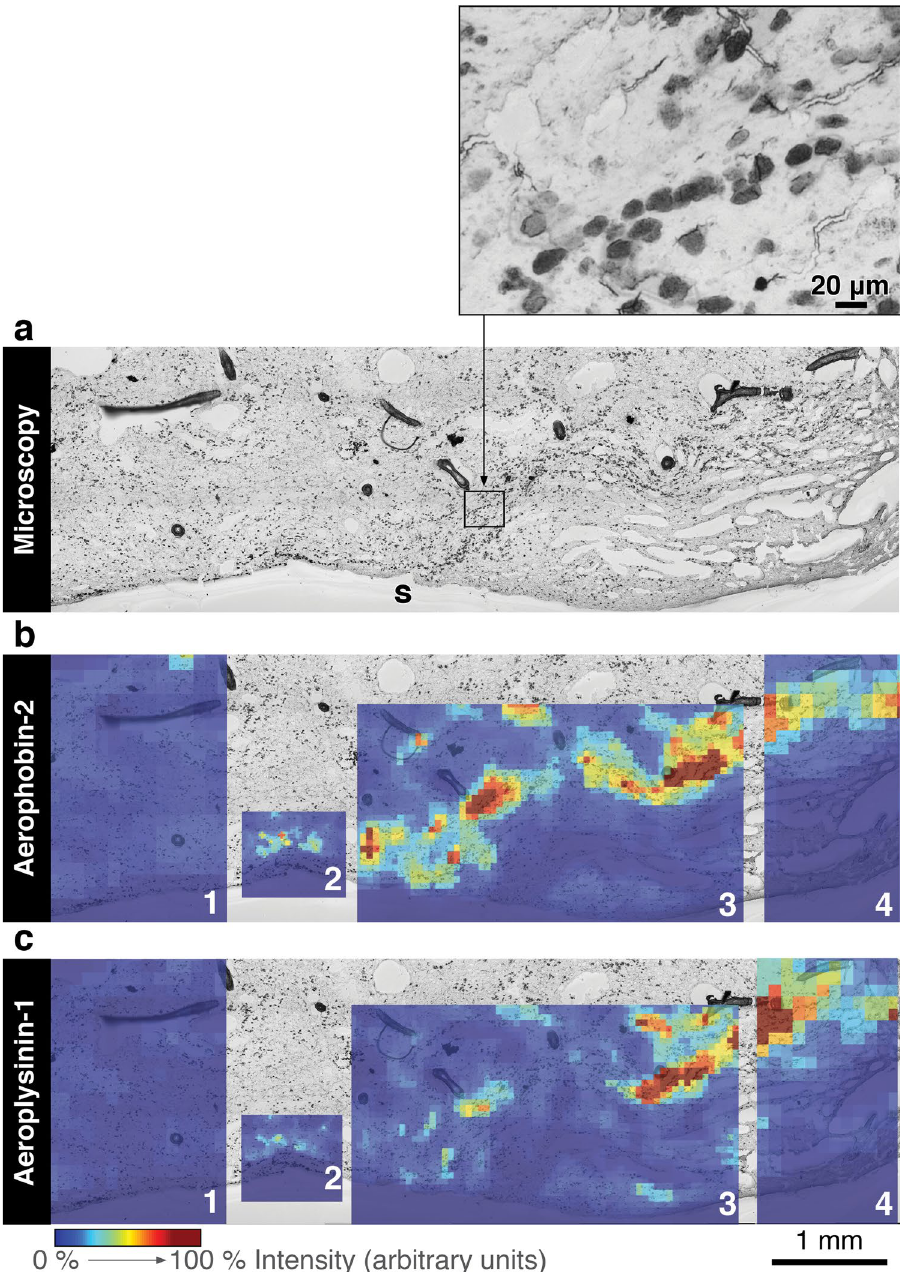
Figure 5. Correlation of cellular pattern and spatial distribution of brominated compounds. ( a ) Light microscopic image of a grazed sample collected from the field. A track of spherulous cells was parallel to the surface beneath the subdermal spaces below surface (s). The size, shape and location of the main cell type (a size from 10 to 20 μm, densely-packed spherule-like structures, location beneath subdermal spaces) resembled that of spherulous cells, as shown in the insert. Superimposition of the microscopic image with 2D-MALDI-images of aerophobin-2 ( b ) and aeroplysinin-1 ( c ), respectively. The sample was measured by MALDI-imaging MS with a raster size at 100 μm (1 and 4), 50 μm (3), and 20 μm (2). The relative intensity of each compound is depicted in a colour scale. The superimposition of microscopic images was generated in SCiLS Lab 2015b (Bruker;